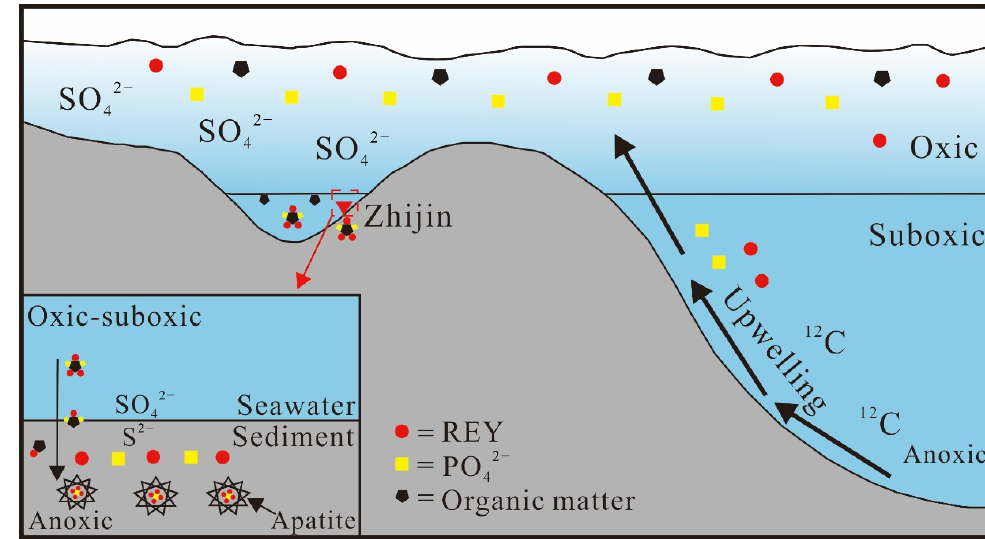
Figure 10. Diagram of REY enrichment process in Zhijin phosphorite.